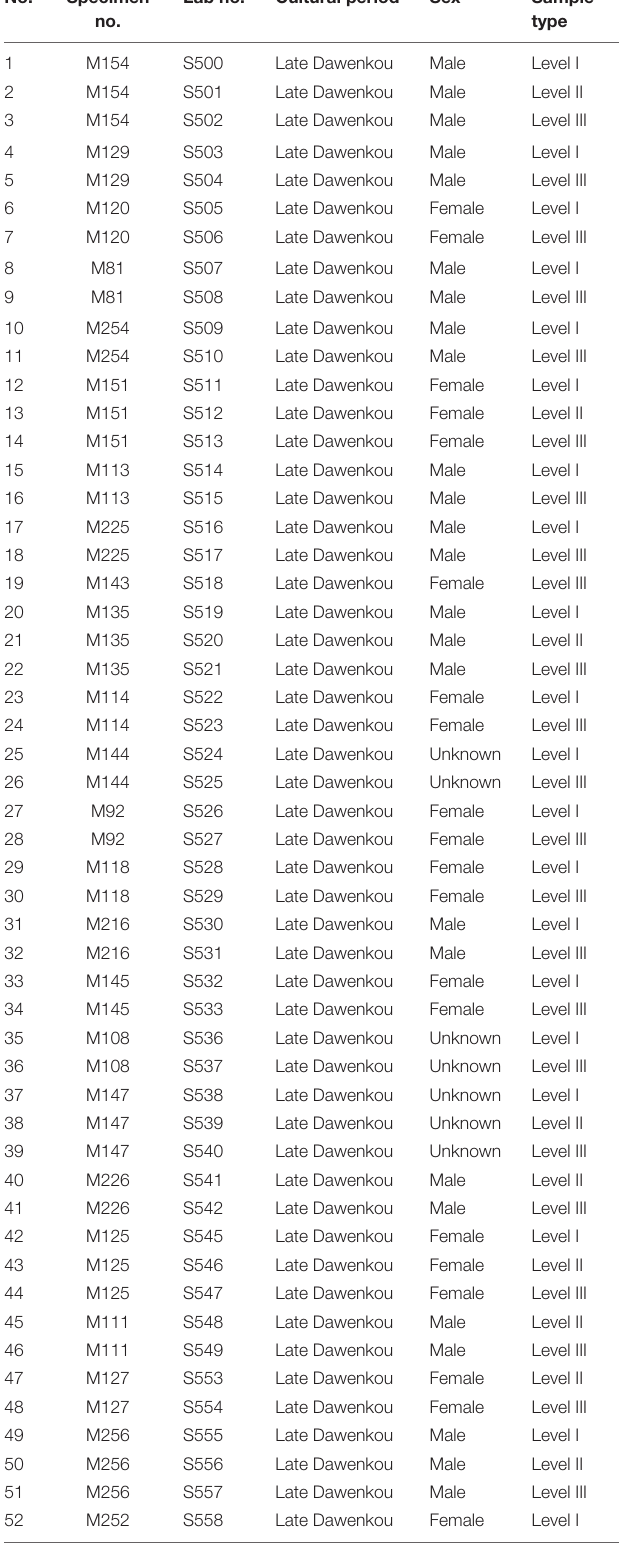
TABLE 1 | Liangwangcheng residue sample information. No. Specimen